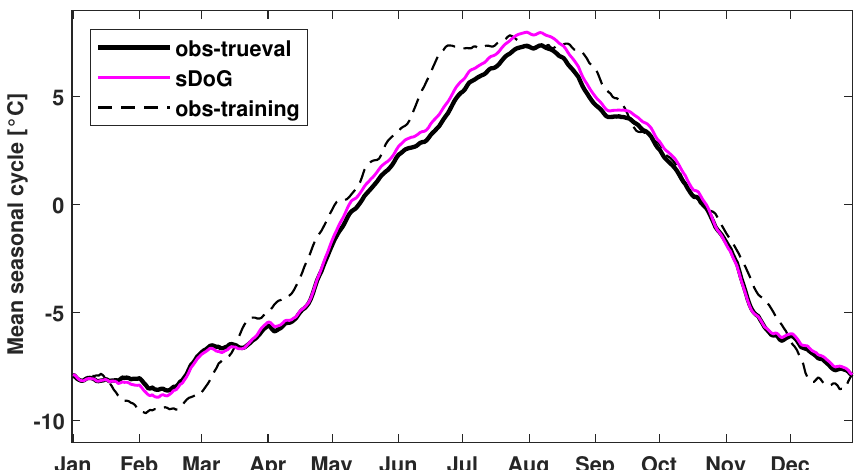
Figure 5. Mean seasonal cycle of VERNAGT air temperature: obs-trueval (black line), sDoG (true evaluation period, magenta) and obs-training (black dashed line). The seasonal cycles are calculated as moving average centered on each day of year with a window size of 20